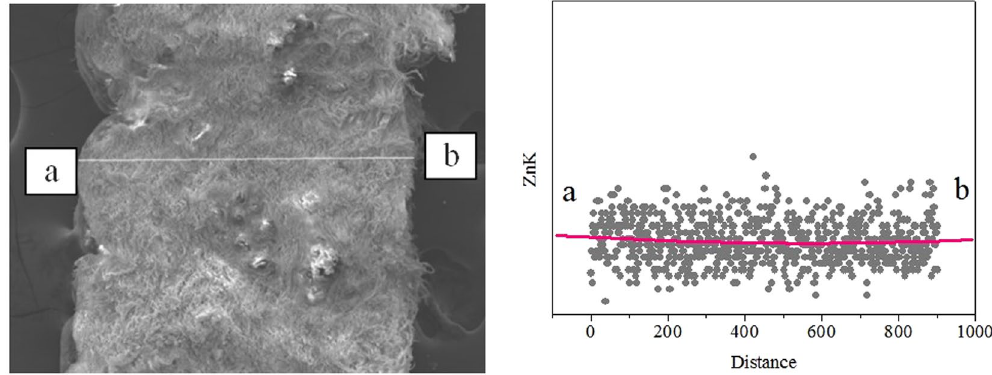
Figure 10. SEM-EDS of the longitudinal section of leather fatliquored by MHCO/GPTMS-ZnO composites.